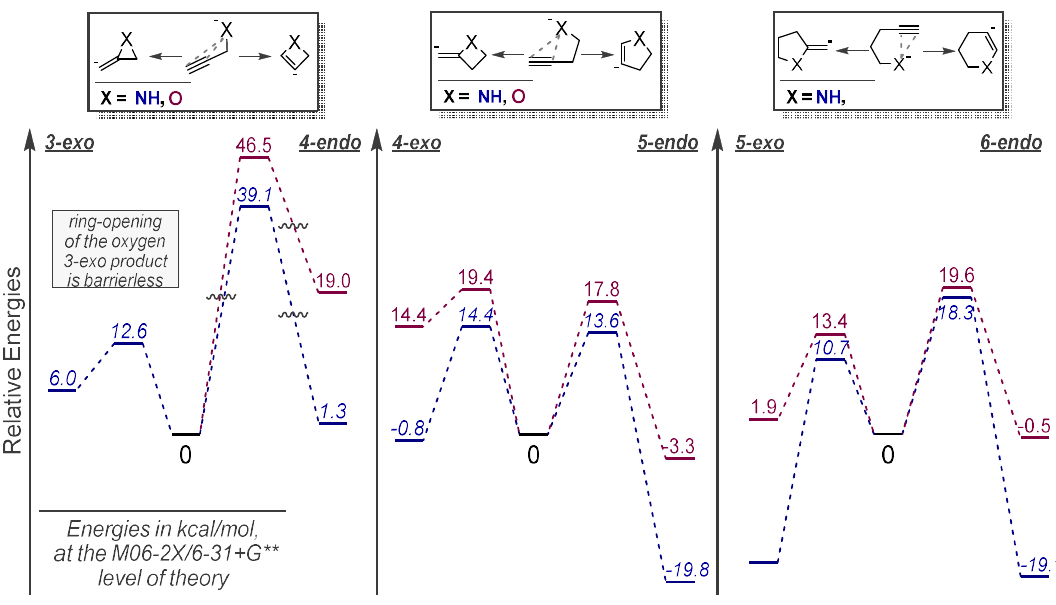
Scheme 14. Potential energy surfaces for selected exo-dig and endo-dig anionic cyclizations of N